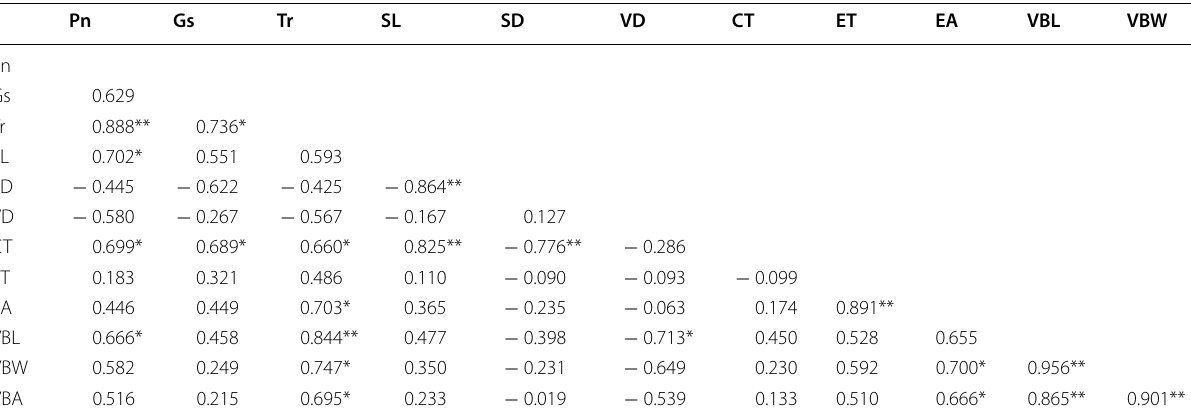
Table 2 Correlations among hydraulic traits of Schoenoplectus tabernaemontani